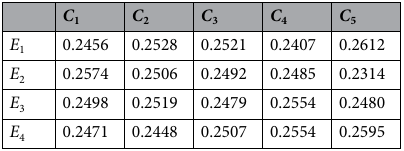
Table 6. Decision makers’ weights on all attributes.